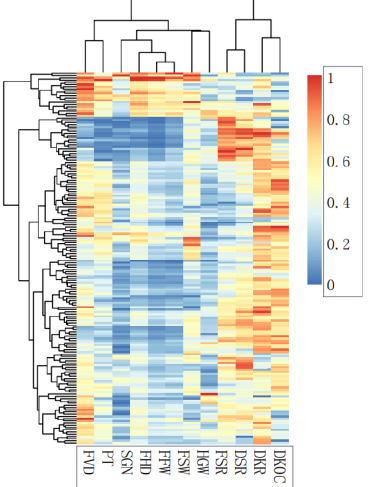
Figure 2. Clustering heat map of fruit traits.